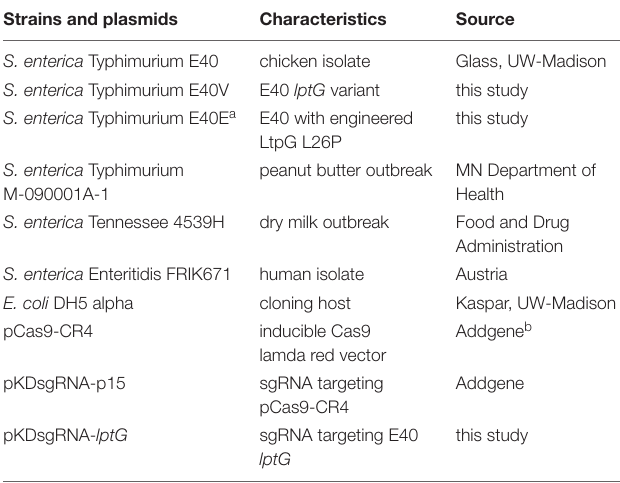
TABLE 1 | Strains and plasmids used in this